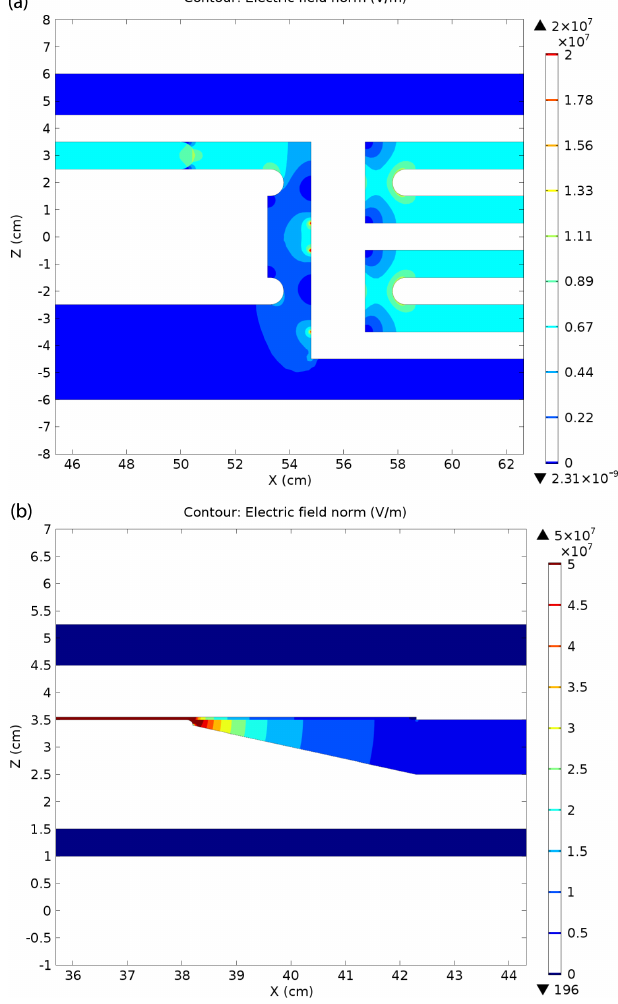
FIG. 9. (a) Close-up view of electric fields in critical DI water- rexolite transition. (b) Rexolite-Kapton